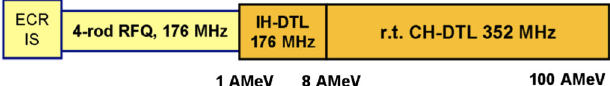
FIG. 32. Schematic layout of an IH/CH-DTL for the production of b-beams.